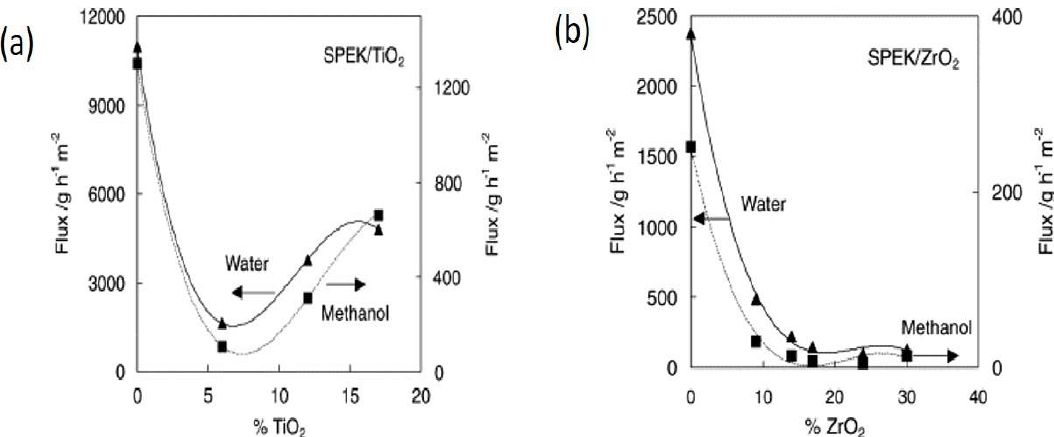
Figure 6. Methanol and water flux in pervaporation experiments at 55 °C post modification of a SPEK membrane with ( a ) TiO 2 and ( b ) ZrO 2 . Reprinted with permission from [72]. Copyright (2002) Elsevier Science B.V.